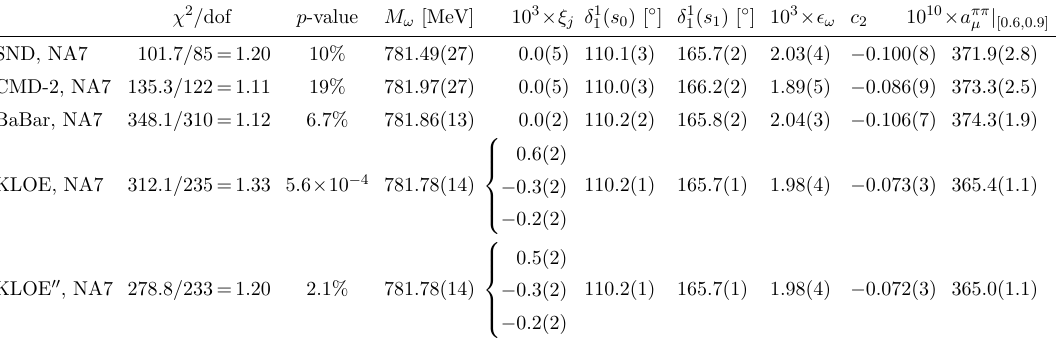
Table 7. Combined (cid:12)ts to one time-like experiment and the space-like NA7 data set. In the KLOE 00 set, the two outliers in KLOE08 have been removed. No rescaling of s has been applied to the space-like